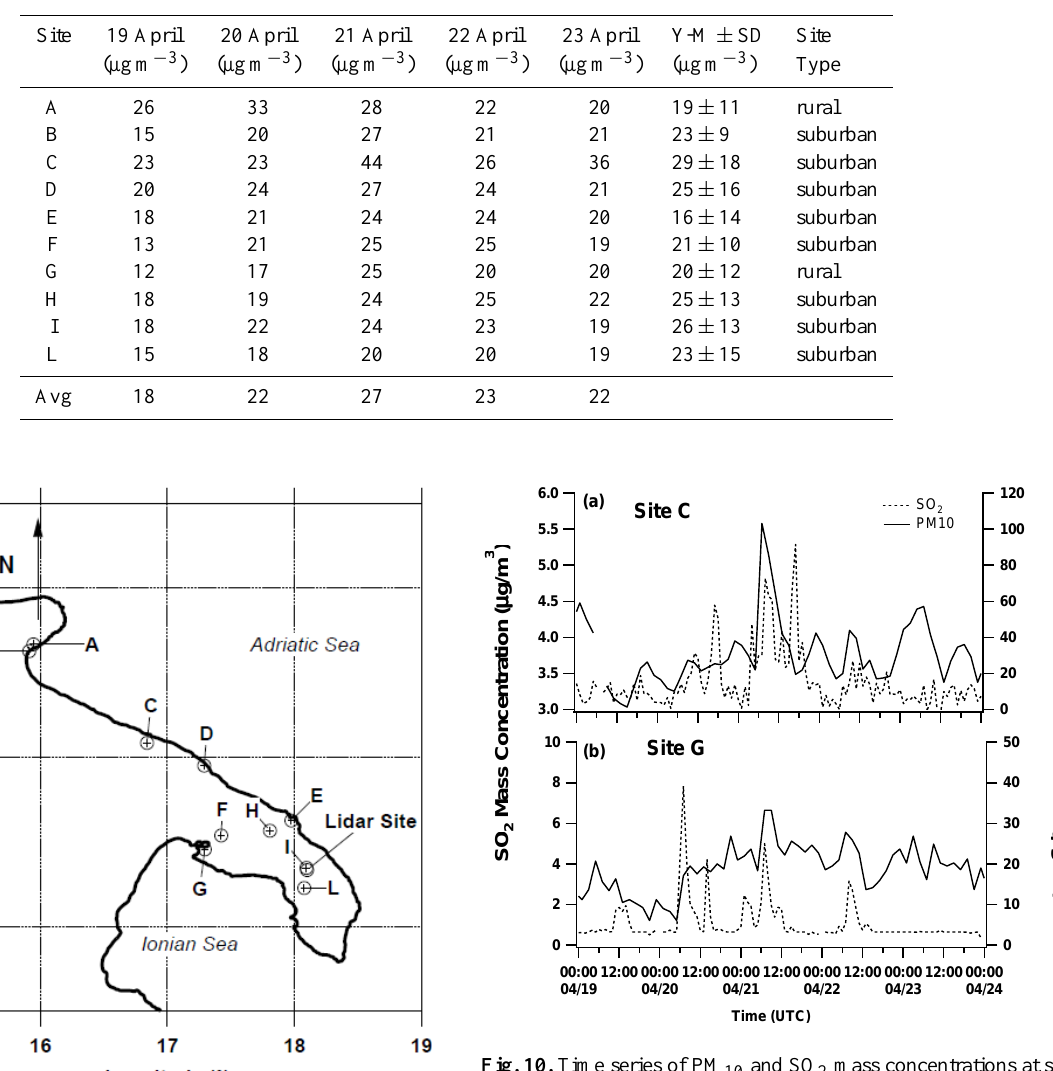
Fig. 10. Time series of PM 10 and SO 2 mass concentrations at sites C and G (locations are shown in Fig. Figure 9 (M. R. Perrone et al.)